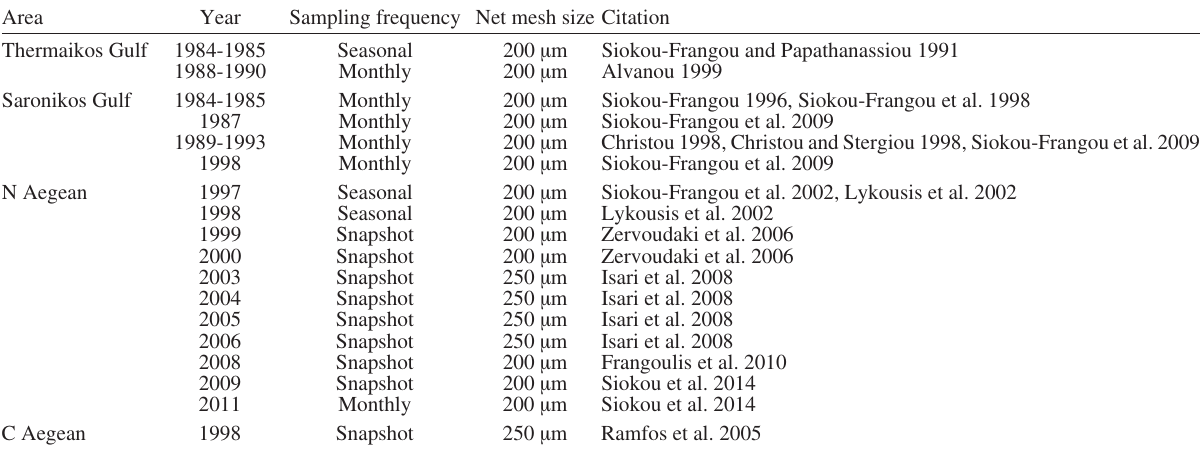
Table 1. – List of selected publications on marine mesozooplankton in the Aegean